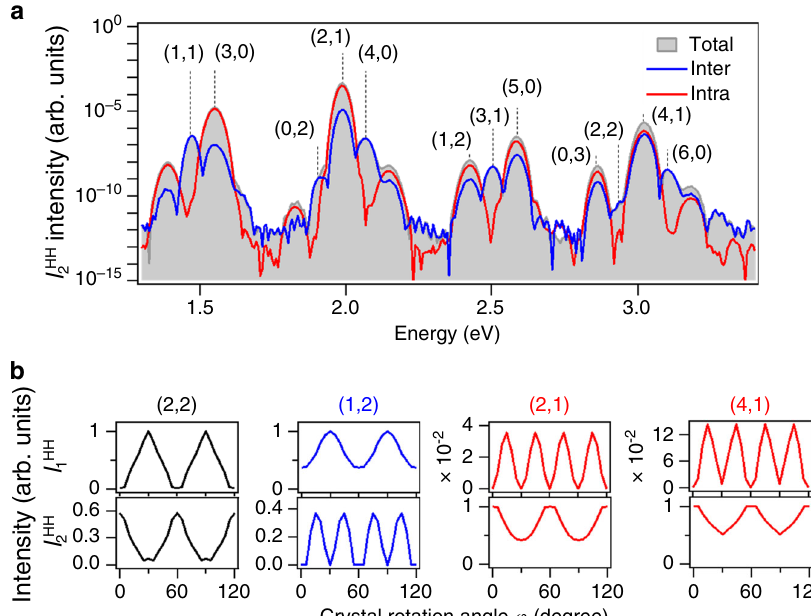
component into interband and intraband 2 or I HH for each order is normalized, 1 2